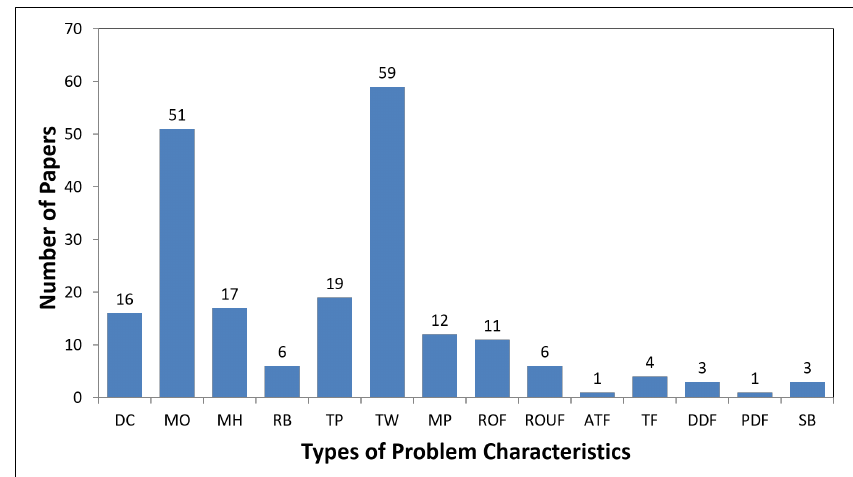
Figure 7. Distribution of Papers based on the Problem Characteristics.